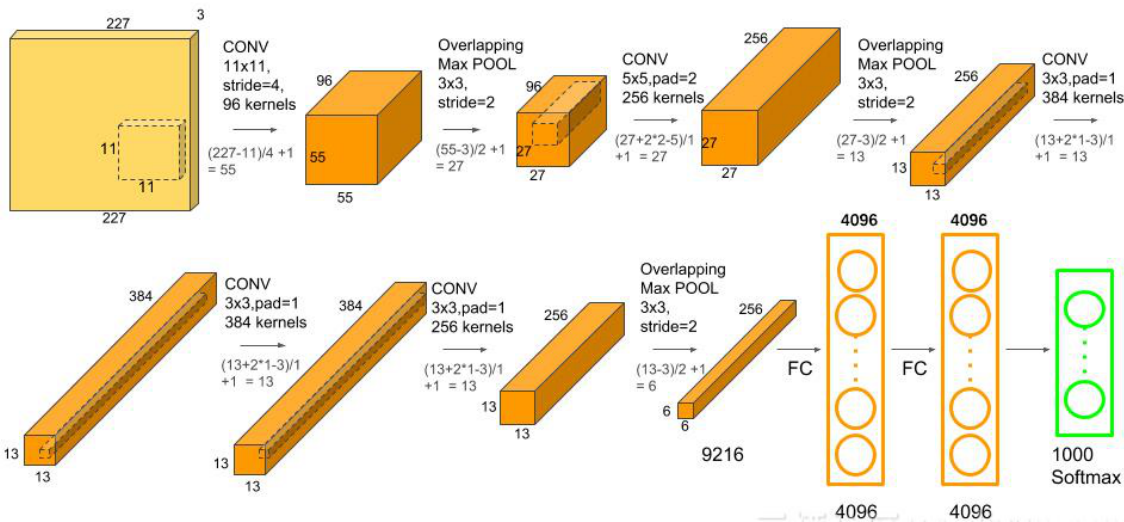
Figure 2. AlexNet network